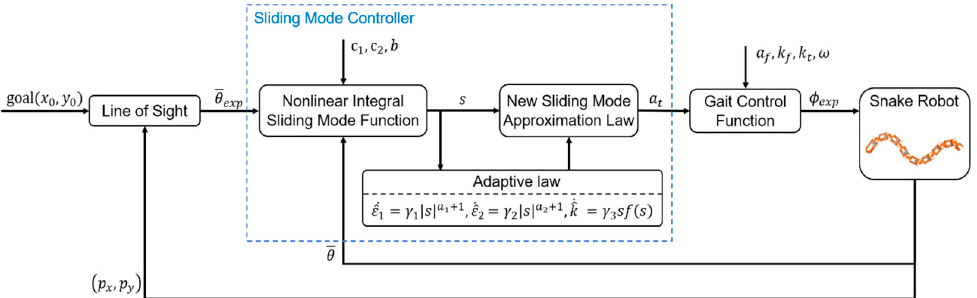
Figure 8. The structure of target tracking controller.